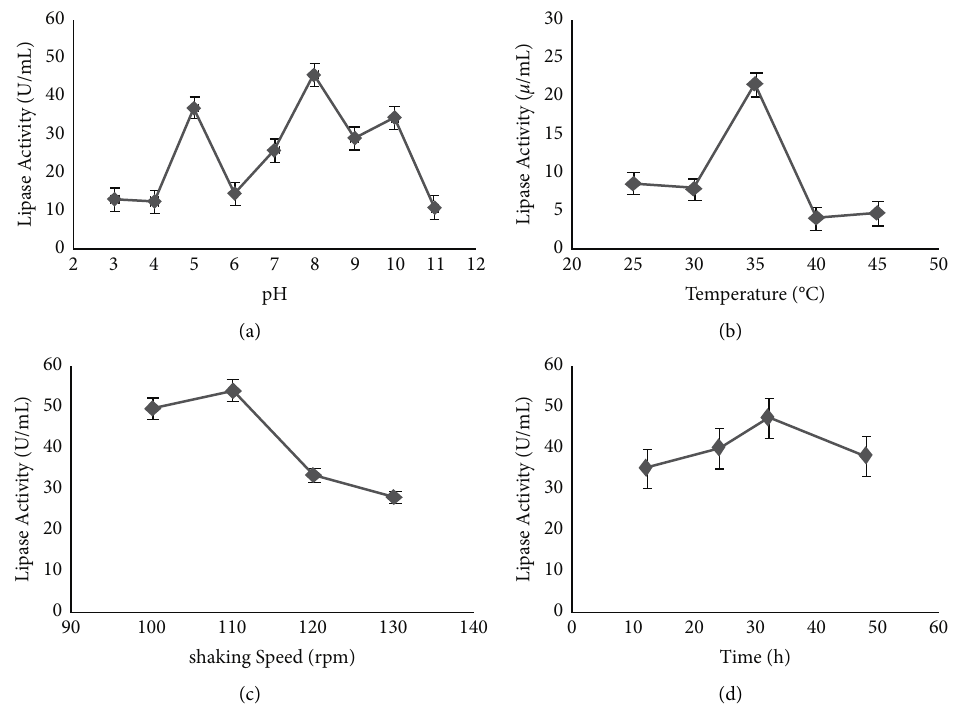
Figure 2: Effects of initial pH (a), temperature (b), and shaking speed (c) on lipase production by K . flava Y4.